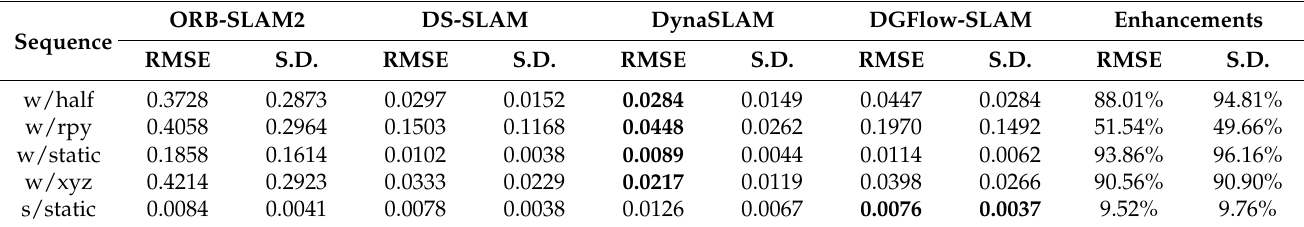
Table 2. Results of translation relative pose error (RPE translation).